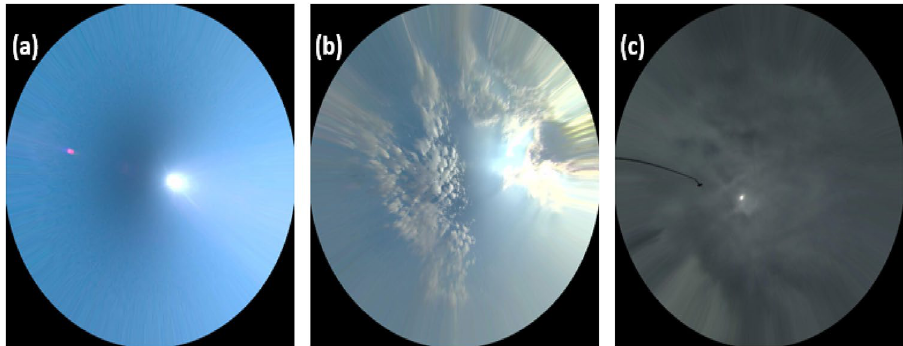
Figure 4. Sky image for the PV operation condition. ( a ) Clear sky. ( b ) Partial shading. ( c ) Overcasting. These images were taken using TSI 440A total sky imager. The temperature of the PV modules at these conditions is 26, 23 and 19 °C, respectively; and the solar radiation is 730, 677, and 408 W/m 2 .